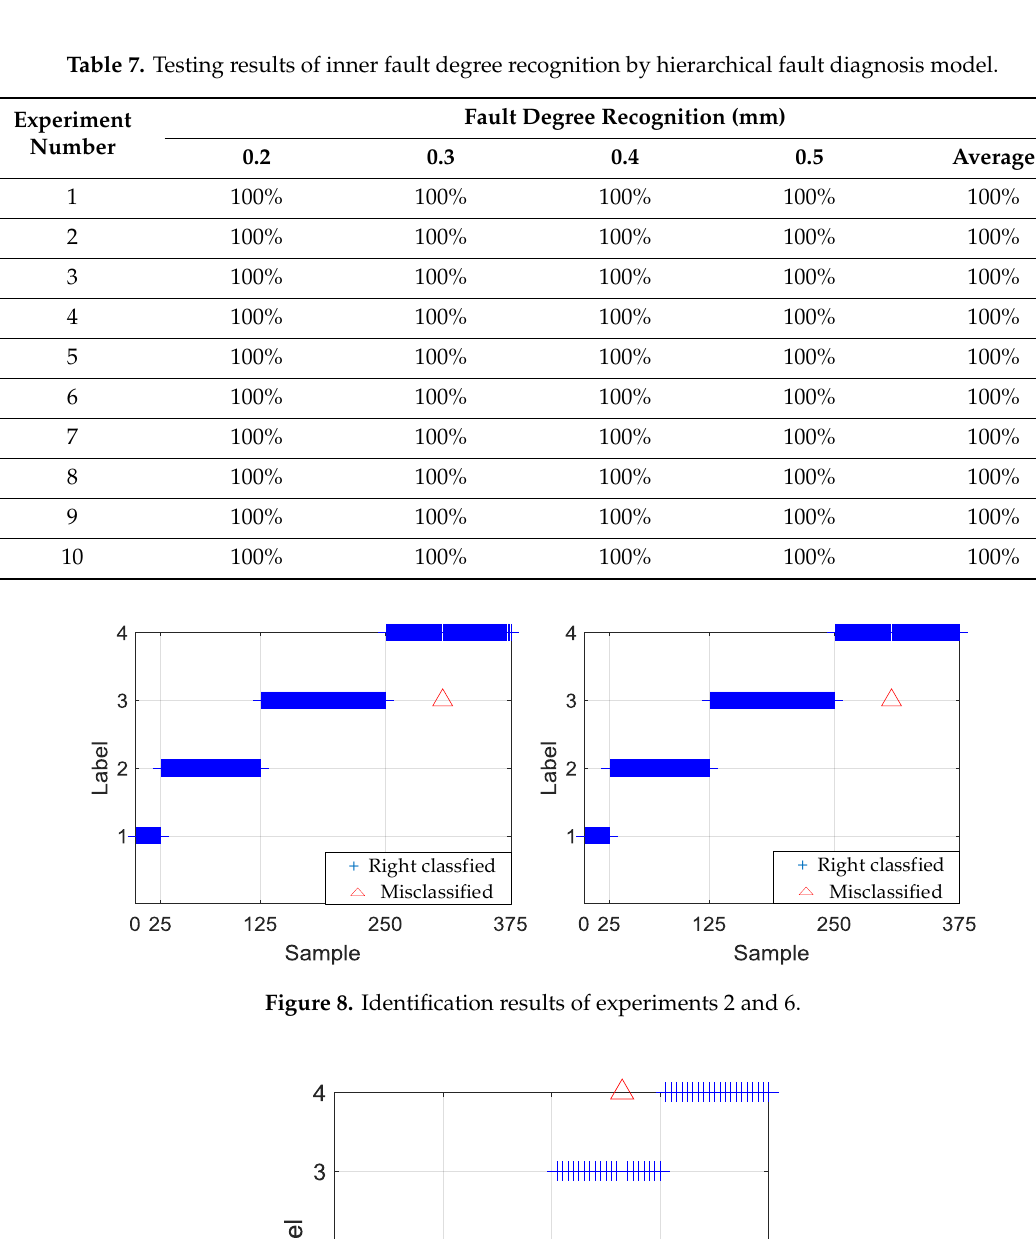
Table 7. Testing results of inner fault degree recognition by hierarchical fault diagnosis model.